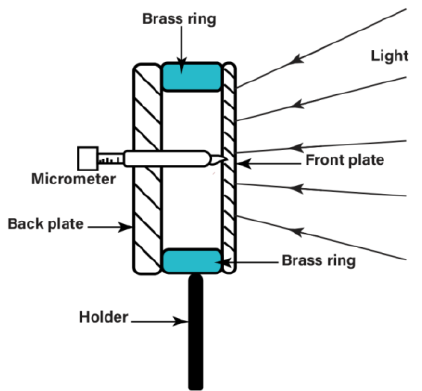
Figure 3. Details of the test object used to produce known deformations (modified from Abedin, et.al., Proc. SPIE 2019, 11100, 1110001-7, Ref. [11]). Proc. SPIE 2019, 11100, 1110001-7, Ref. [11]).